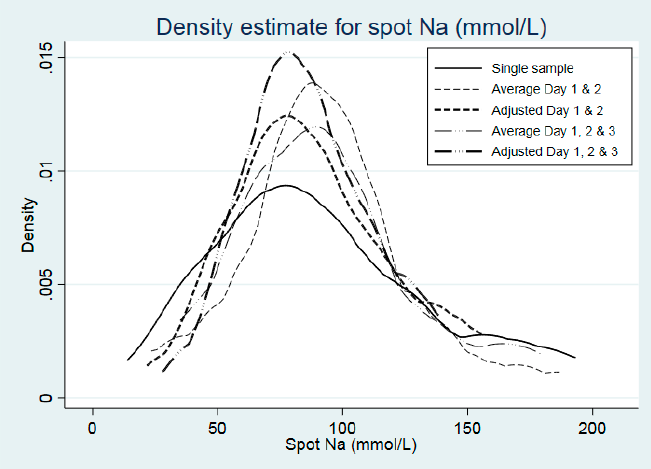
Figure 1. Population distribution of urinary spot Na (mmoL/L), according to number of days of urine collection ( n = 23). Density refers to proportion of persons, e.g. 0.005 = 0.5%). Solid line: raw data from day1 only; thin dashed line: after correction for average of day1 and day2; thick dashed line after correction for intra-individual variation of day1 and day2; thin long dashed & dotted line: after correction for average of all three days; thick long dashed & dotted line after correction for intra-individual variation of all three days.